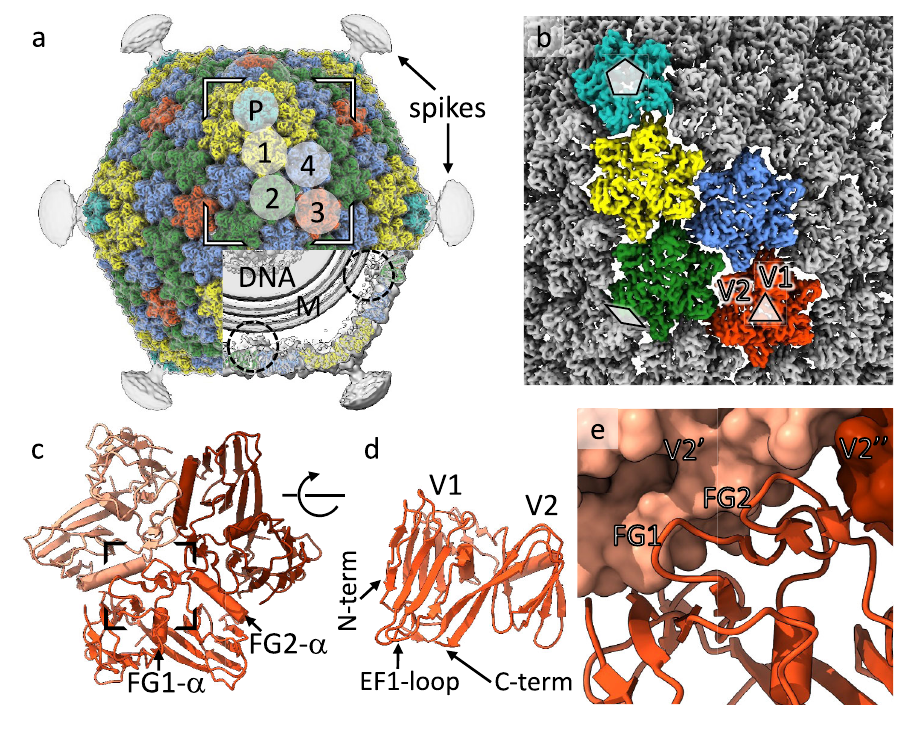
Fig.2|Structureofthe Φ CjT23bacteriophagecapsidandmajorcapsidprotein trimer. a Surface rendering of the Φ CjT23 virion cryo-EM map at 4.1Å resolution. The four different types of major capsid protein trimers are colored yellow (1), green (2), red (3) and blue (4). The penton base (P) is colored cyan with the remainingstructuralcomponentscoloredgray.Ontop,agraytransparentsurface, calculated from the cryo-EM map fi ltered to 12Å resolution, is shown. This lower- resolution surface reveals disordered density attributed to fl exible spikes which originatefromthepentonbases.Apartofthedensityisremoved,torevealthelipid bilayer (M), DNA, and putative minor protein components (circles) bridging